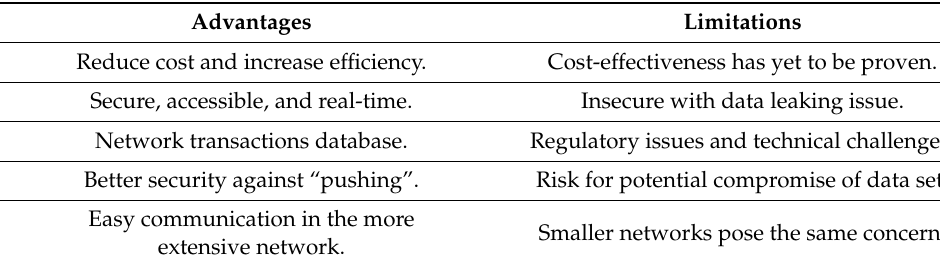
Table 1. The advantages and limitations of blockchain